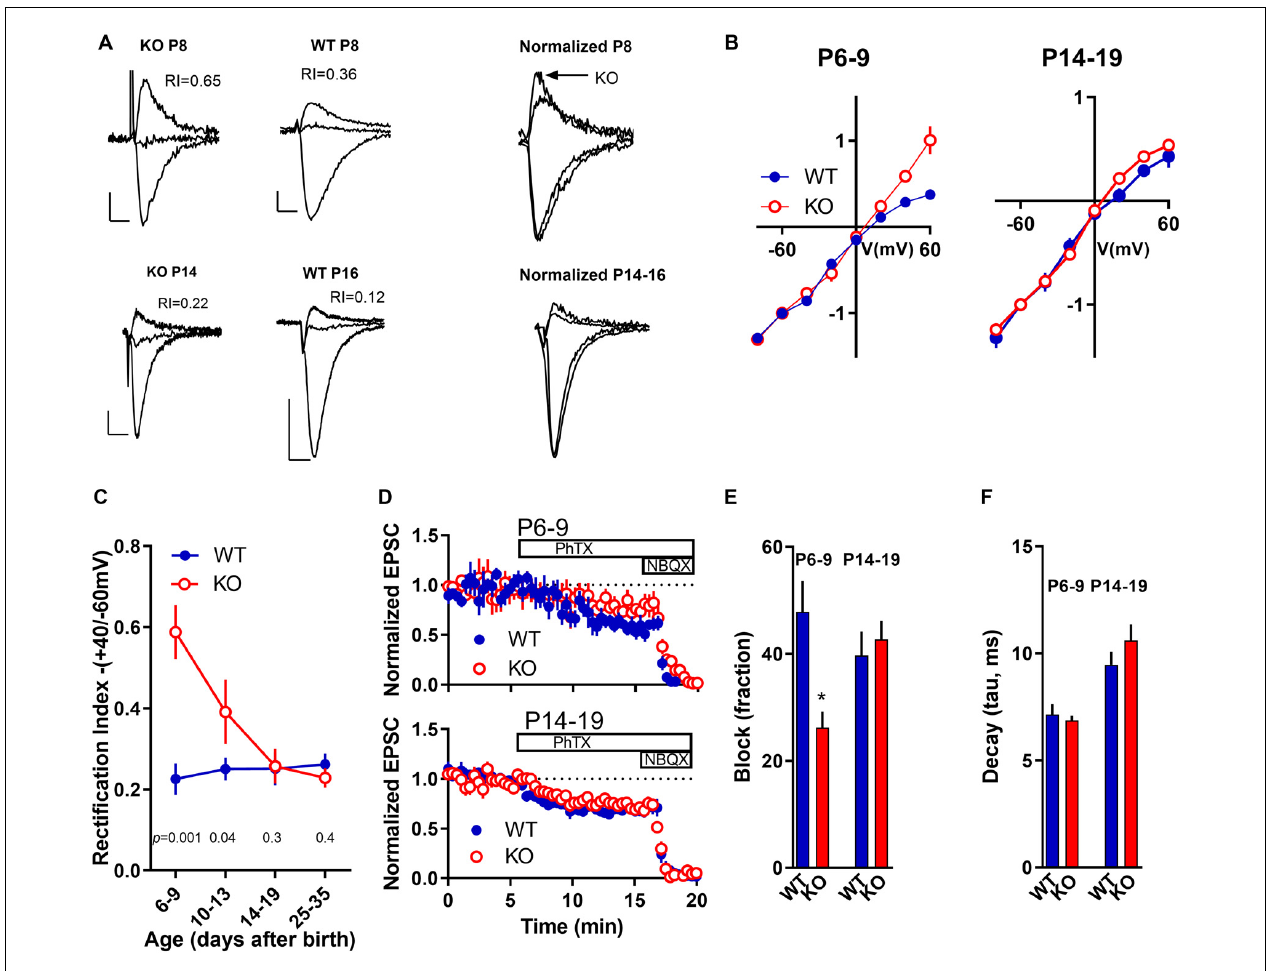
FIGURE 2 | Developmental subunit composition of synaptic AMPARs in the FMRP KO. (A) Sample traces of AMPAR EPSCs recorded at − 60, 0, and +40 mV in the presence of 100 µ M DL-2-Amino-5-phosphonopentanoic acid (APV) in CA1 neurons from FMRP KO or WT neurons as indicated. To the right are the same traces with amplitude normalized to − 60 mV. Scale bar = 10 ms and 50 pA. (B) Normalized current-voltage plot from P6–9 and P14–19 neurons from KO (white dots; n = 13–22) and WT slices (black dots; n = 8–25). (C) Rectification Index (RI) was calculated as the ratio of responses at +40 mV and − 60 mV for KO neurons (white dots) and WT neurons (black dots). n values for WT neurons from P6–9 to P > 30 are: 16, 17, 9, 5. n values for KO neurons from P6–9 to P > 30 are: 10, 11, 17, 10. Student’s t -test p -value comparing KO vs. WT at each specific age is indicated in the figure. (D) Blockade of AMPAR-mediated currents with PhTx-74. After a 5 min baseline, PhTx was applied to the perfusion bath. Then, 20 µ M of the general AMPAR blocker NBQX was added to the bath. Effect of PhTx in slices P6–9 (top) and in P14–19 (bottom) in WT neurons (black dots; n = 6–8) and KO neurons (white dots; n = 7–8). (E) The fraction of PhTx-74 blockade measured at the 15–18 min time window in slices as indicated. The asterisk indicates p < 0.05 significant difference between P6–9 WT and KO. (F) The decay phase of AMPAR-mediated responses was fitted with a single exponential curve and the time constant (tau) was estimated. No significant differences between WT and KO neurons at each age group were